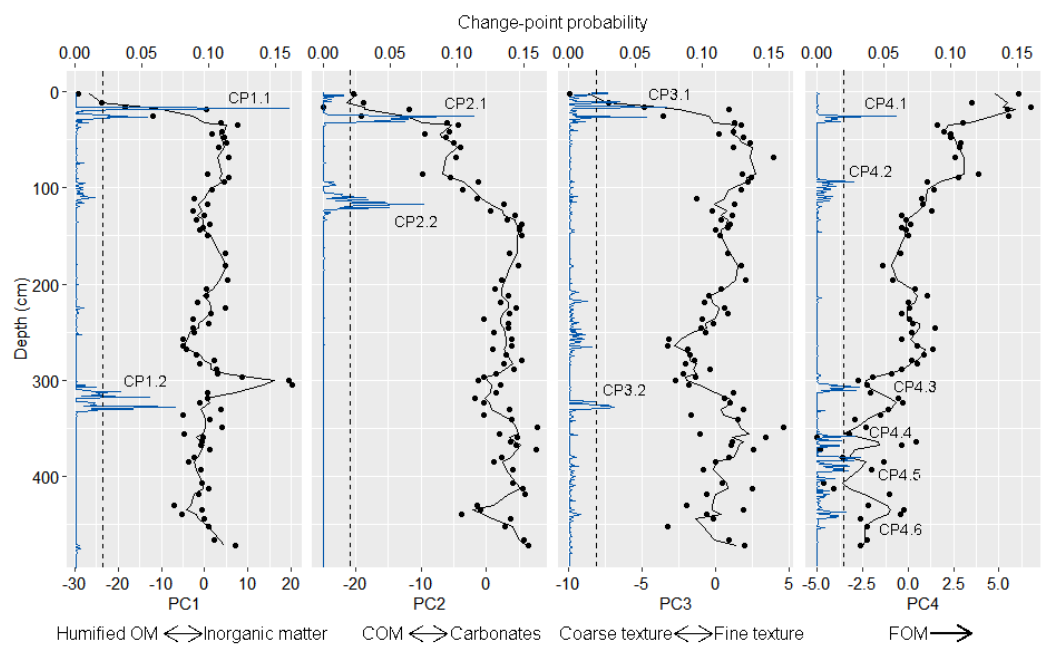
Figure 3. Depth records of principal components (PCs) scores, dots; moving average of PCs scores, grey line. Change point probability, blue line; limit to consider a change point (0.02), black dashed line.